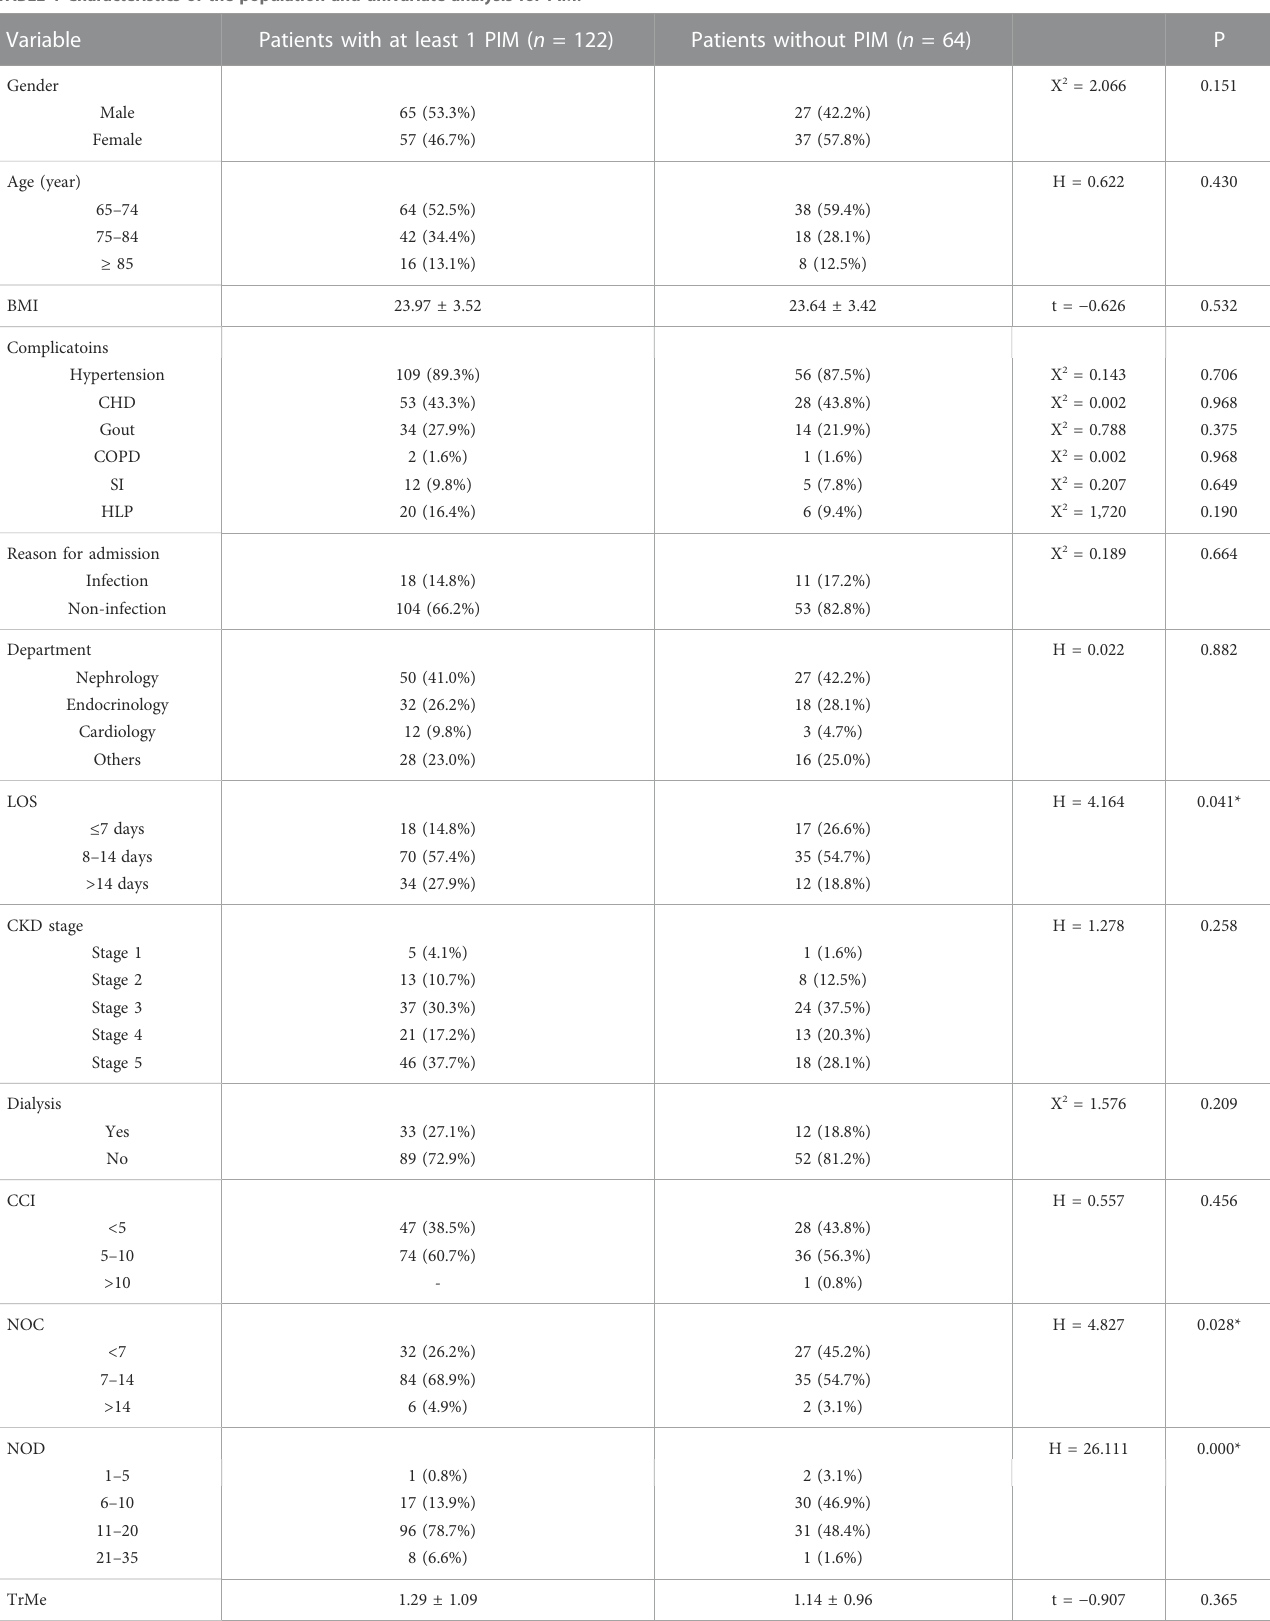
TABLE 1 Characteristics of the population and univariate analysis for